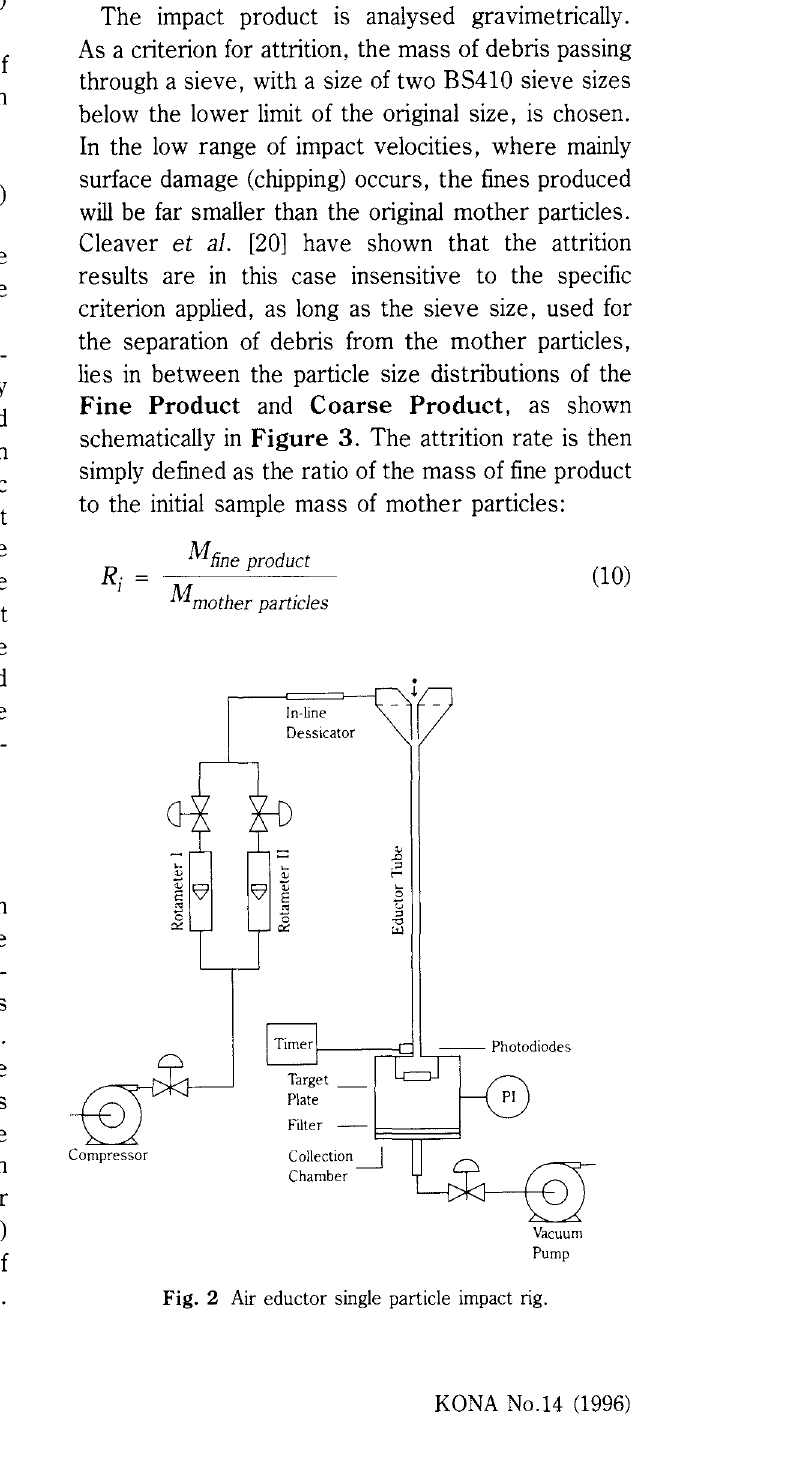
Fig. 2 Air eductor single particle impact